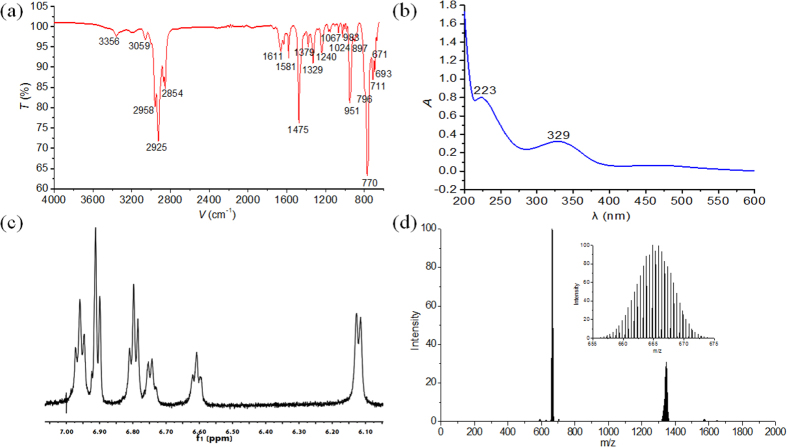
The spectra and ESI-MS characterizations of compound 1.(a) IR, (b) UV-Vis, (c) 1H NMR spectra and (d) ESI-MS.